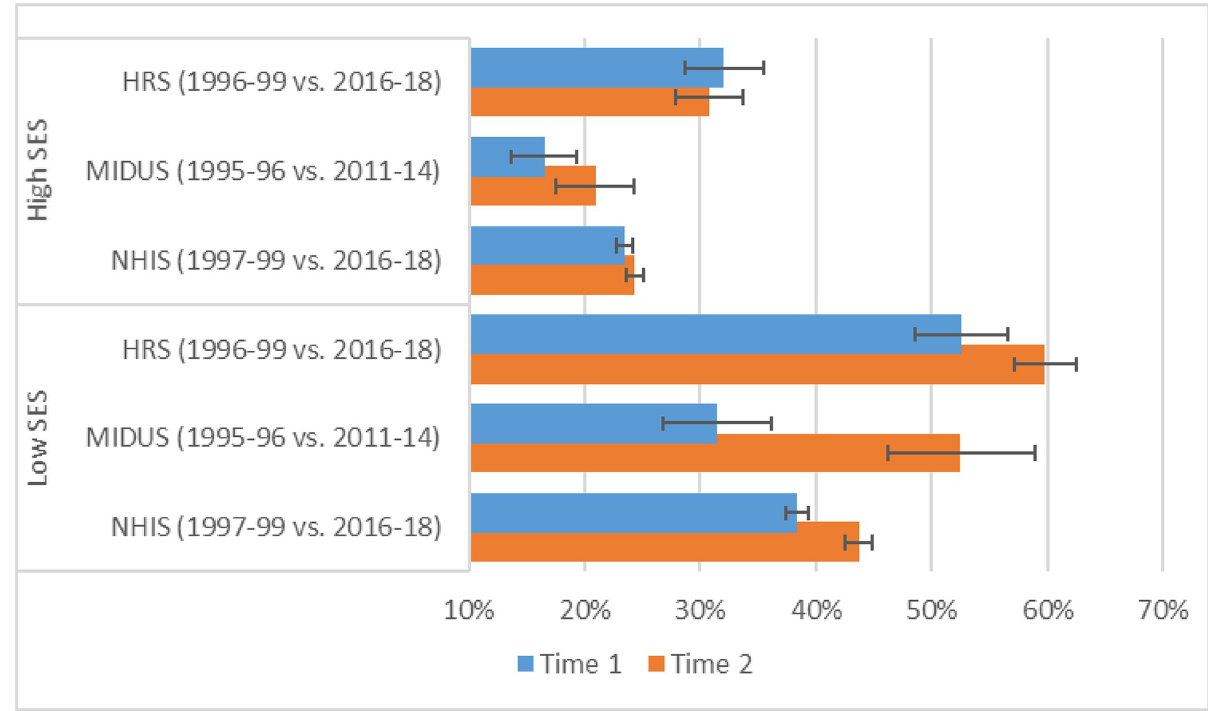
Fig 10. Predicted prevalence of back pain at age 50 by survey and period for low versus high SES. These predicted probabilities were based on models that adjusted for sex, age (quadratic specification), race/ethnicity, period (categorical specification), and SES. The models included the following 2-way interactions: age (quadratic) x period; age (quadratic) x SES; and period x SES. They also included a 3-way interaction between age (linear), period, and SES. We compute the probabilities for someone aged 50 at the 10th (low SES) vs. the 90th (high SES) percentiles of SES for the specified periods; all other covariates were fixed at the values observed in the